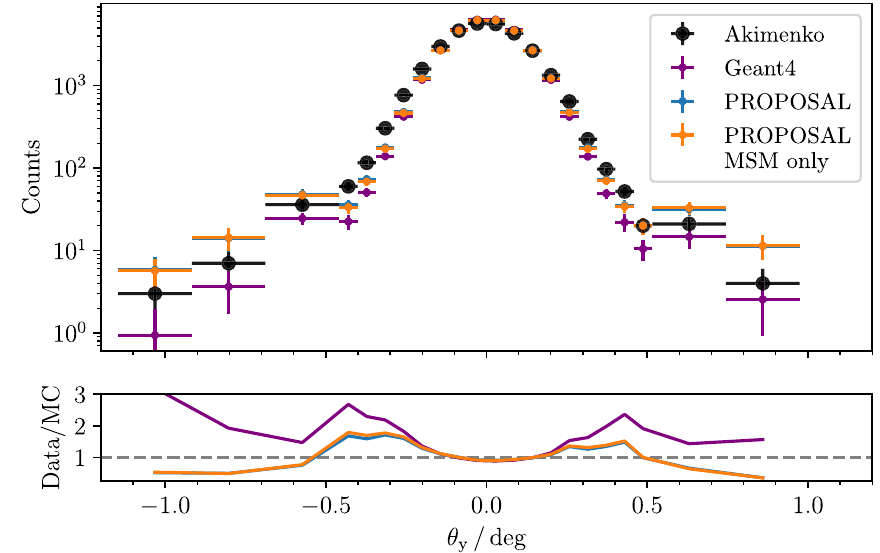
Fig. 4 A comparison between two PROPOSAL simulations and mea- sureddatabyAkimenkoetal.[29]ispresentedforthenormalizedcounts independenceoftheprojectedscatteringangle θ y indegree.Deflections are simulated with Geant4 v11 . 0 . 3 as well. 100 simulations each with 31125 muons with E i = 7 . 301 GeV are propagated through a 1 . 44 cm copper layer. In PROPOSAL the energy cut v cut = 10 − 5 is used. The blue points present the mean of the simulation considering stochastic